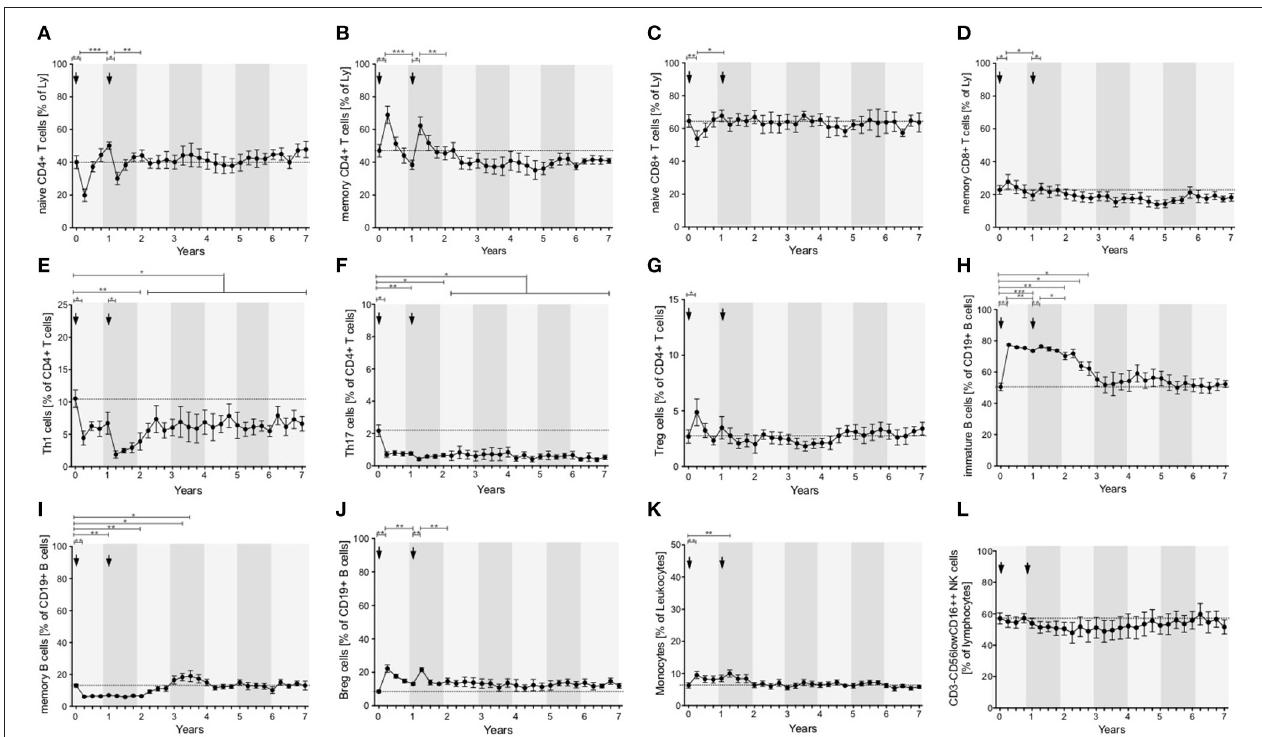
FIGURE 4 | Distribution of peripheral immune cell subsets of patients with stable disease course after 1st and 2nd ATZ (complete-responder). Distribution of relative count of peripheral immune cell subsets before (0 years) and up to 7 years follow up are depicted. Mean values + / − SD of relative count of T cell (A–G) , B cell (H–J) , and innate immune cell (K,L) subsets are presented. Arrows indicate ATZ application. Asterisks indicate a statistically significant difference (* p < 0.05, ** p < 0.01, *** p < 0.001).